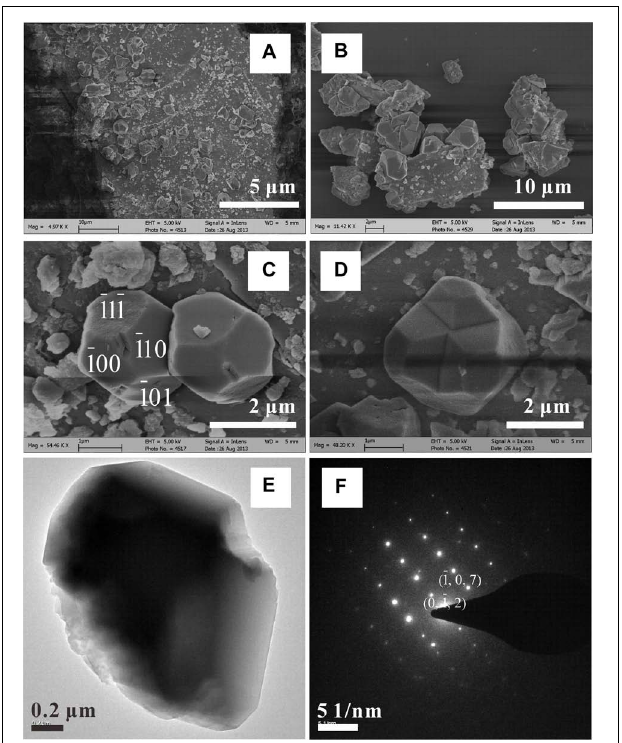
FIGURE 9 | SEM characterizations (A–D) of magnesite crystals formed in the [H 2 O-CO 2 ]-peridotite system at 200 ◦ C. (E) TEM characterization of one single magnesite crystal and the related SAED pattern (F)